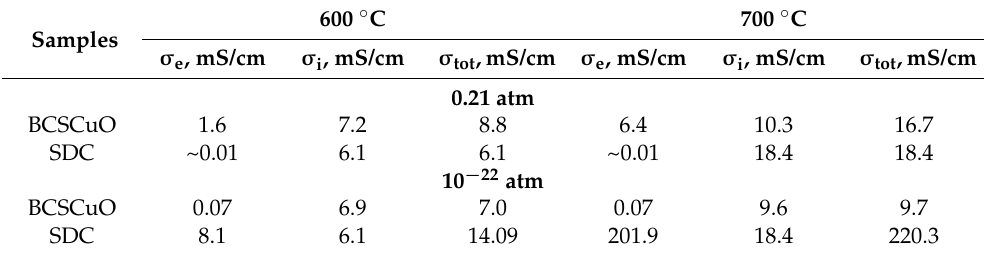
Figure 2. Electrical properties of BCSCuO and SDC compacts: ( a ) Conductivity temperature depen- dences in wet air and wet hydrogen; ( b ) Conductivity dependences on pO 2 at 600 ◦ C and 700 ◦ C. Table 1. The values of the partial and total conductivities for the BCSCuO and SDC compacts at different temperature and pO 2